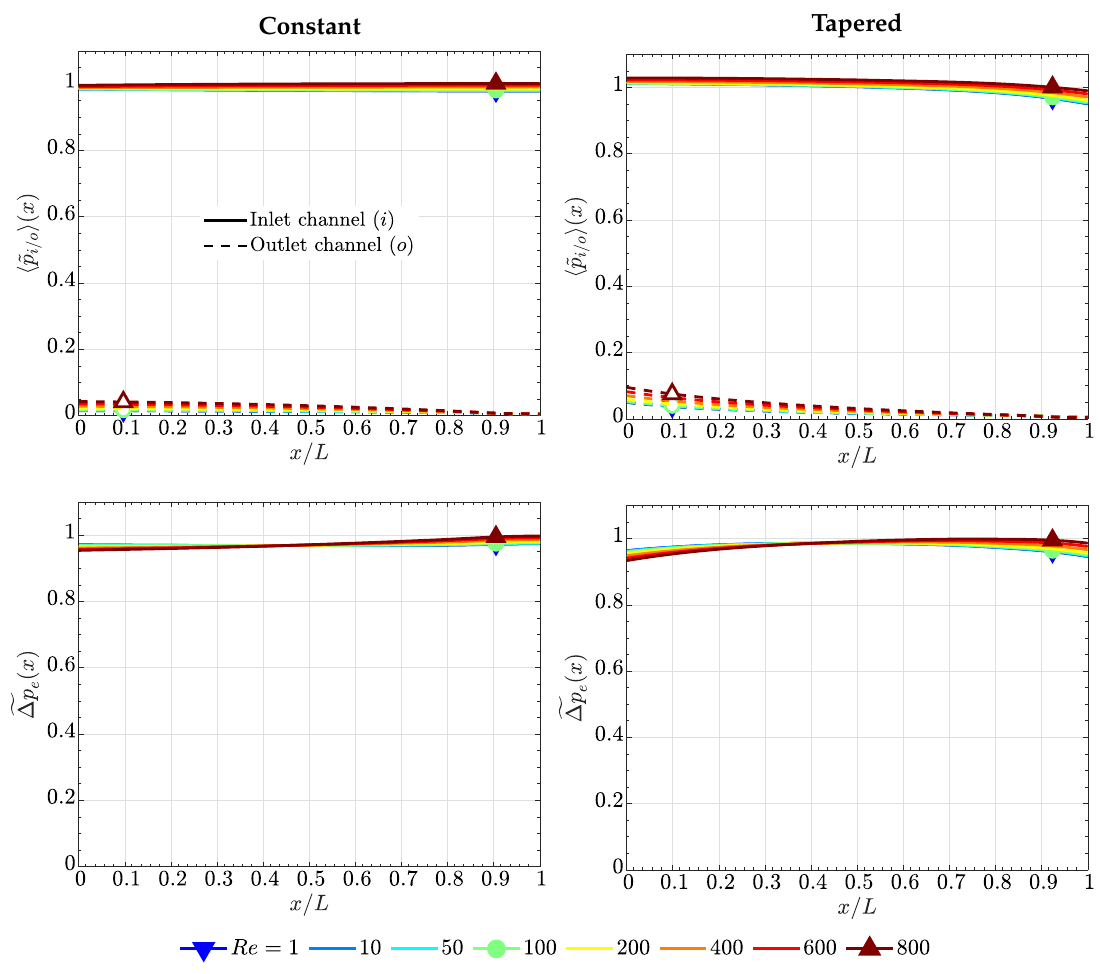
Figure 6. Variation of ( top ) the y -averaged pressure in the inlet and outlet channels, (cid:104) ˜ p i / o (cid:105) ( x ) , and ( down ) the pressure drop across the electrode, (cid:102) ∆ p , as a function of the along-the-channel coordinate, e x / L , for Re = 1 − 800, corresponding to ( left ) the constant cross-section and ( right ) the tapered